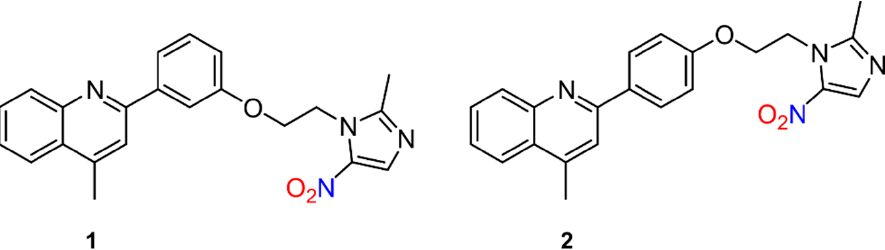
Figure 4. Quinoline–metronidazole derivatives active against visceral leishmaniasis (VL)